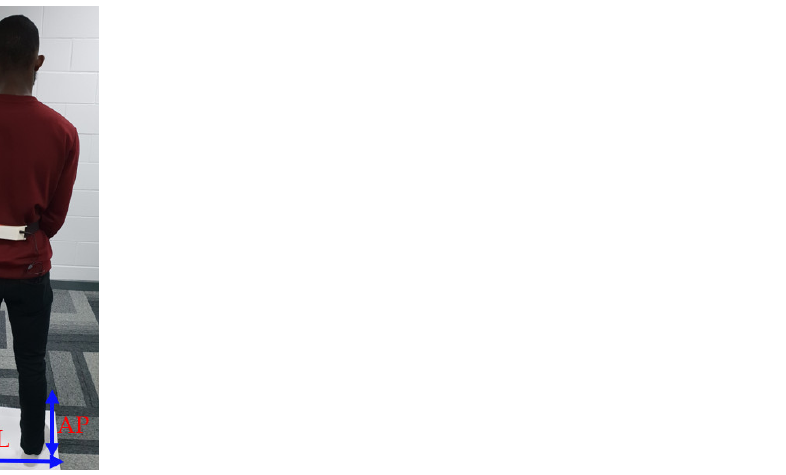
Figure 4. A subject performing condition 3 of the mCTSIB with a white sponge under his feet and the accelerometer transmitter unit (the white box) worn at the lower back.